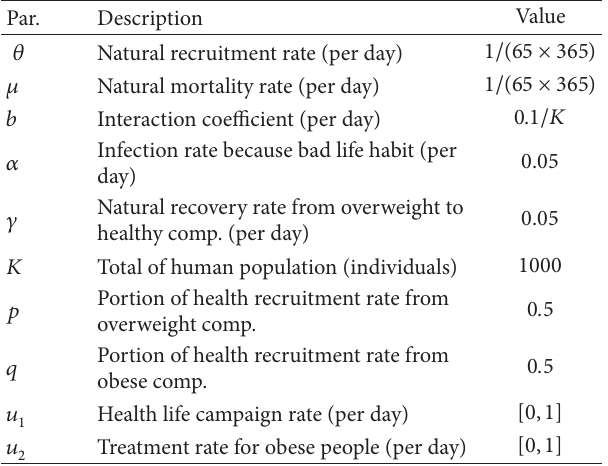
Table 1: Parameters description and value.